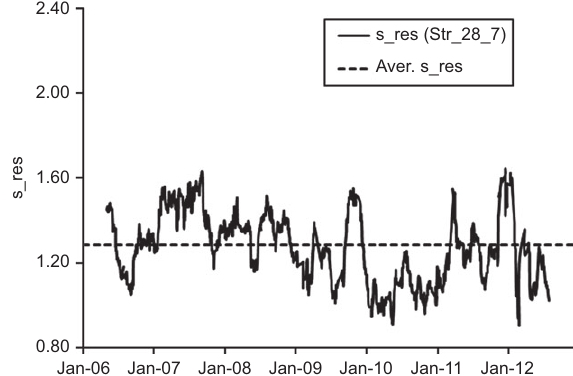
Figure 7 Coefficients of % Clinker and Str_7 for the second model. Figure 9 Residual errors for the second model. static models. The average relative errors, % Error for SMs